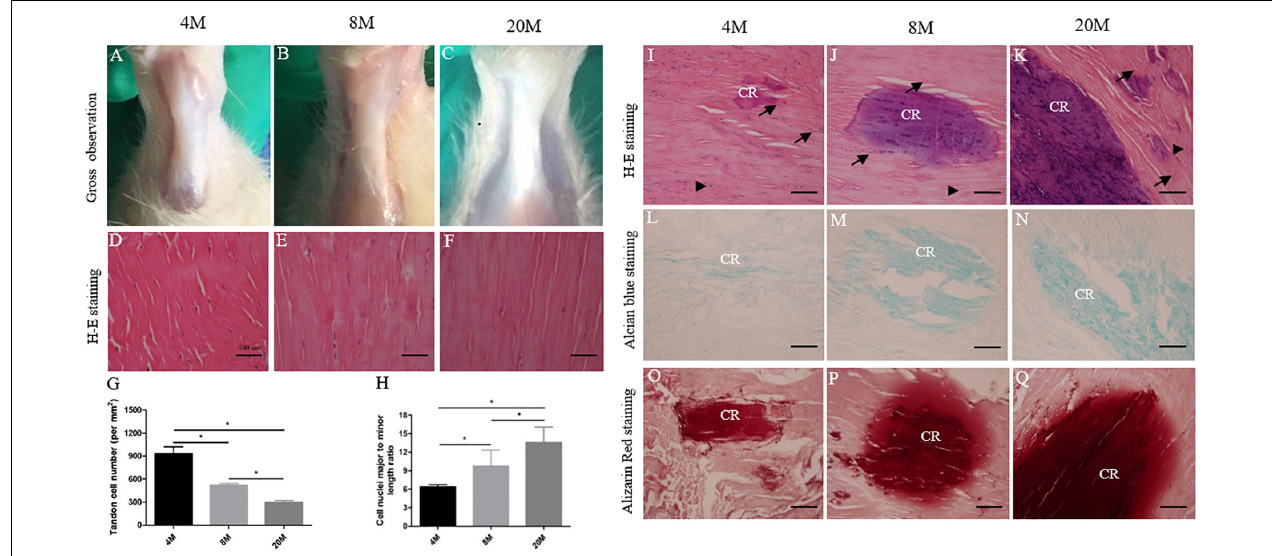
FIGURE 2 | Histological alterations in ossified tendon with aging. Histology analysis. (A–C) Gross observation of Achilles tendon from rats aged 4, 8, and 20 M. (D–F) Representative H&E images of Achilles tendon from rats aged 4, 8, and 20 M mainly focused on tendon cells’ morphological appearance. Statistical diagrams show a decrease in cell number per mm 2 (G) and a more flattened cell nuclei shape (H) in aged Achilles tendon. Representative H&E (I–K) , Alcian blue (L–N) , and Alizarin red (O–Q) staining images of ossified tendon from rats aged 4, 8, and 20 M; the heterotopic ossification was observed and the ossified area size was increased with age. Arrowhead: rounded tendon cells; arrow: chondrocyte-like cells; CR, calcified region. Scale bar = 100 µ m. ∗ P <